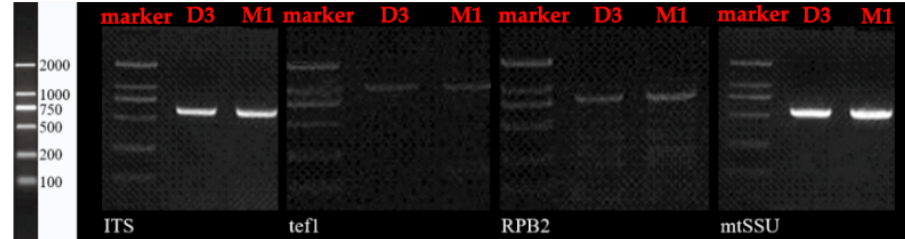
Figure 2. Visualization of the amplification of the four genes (the internal transcribed spacer region (ITS), translation elongation factor alpha 1 ( tef1 ), DNA-directed ribosomal polymerase II ( RPB2 ), and mitochondrial small subunit (mtSSU)) of Amylostereum isolates from Sirex , on a 1.5% agarose gel stained with ethidium bromide.